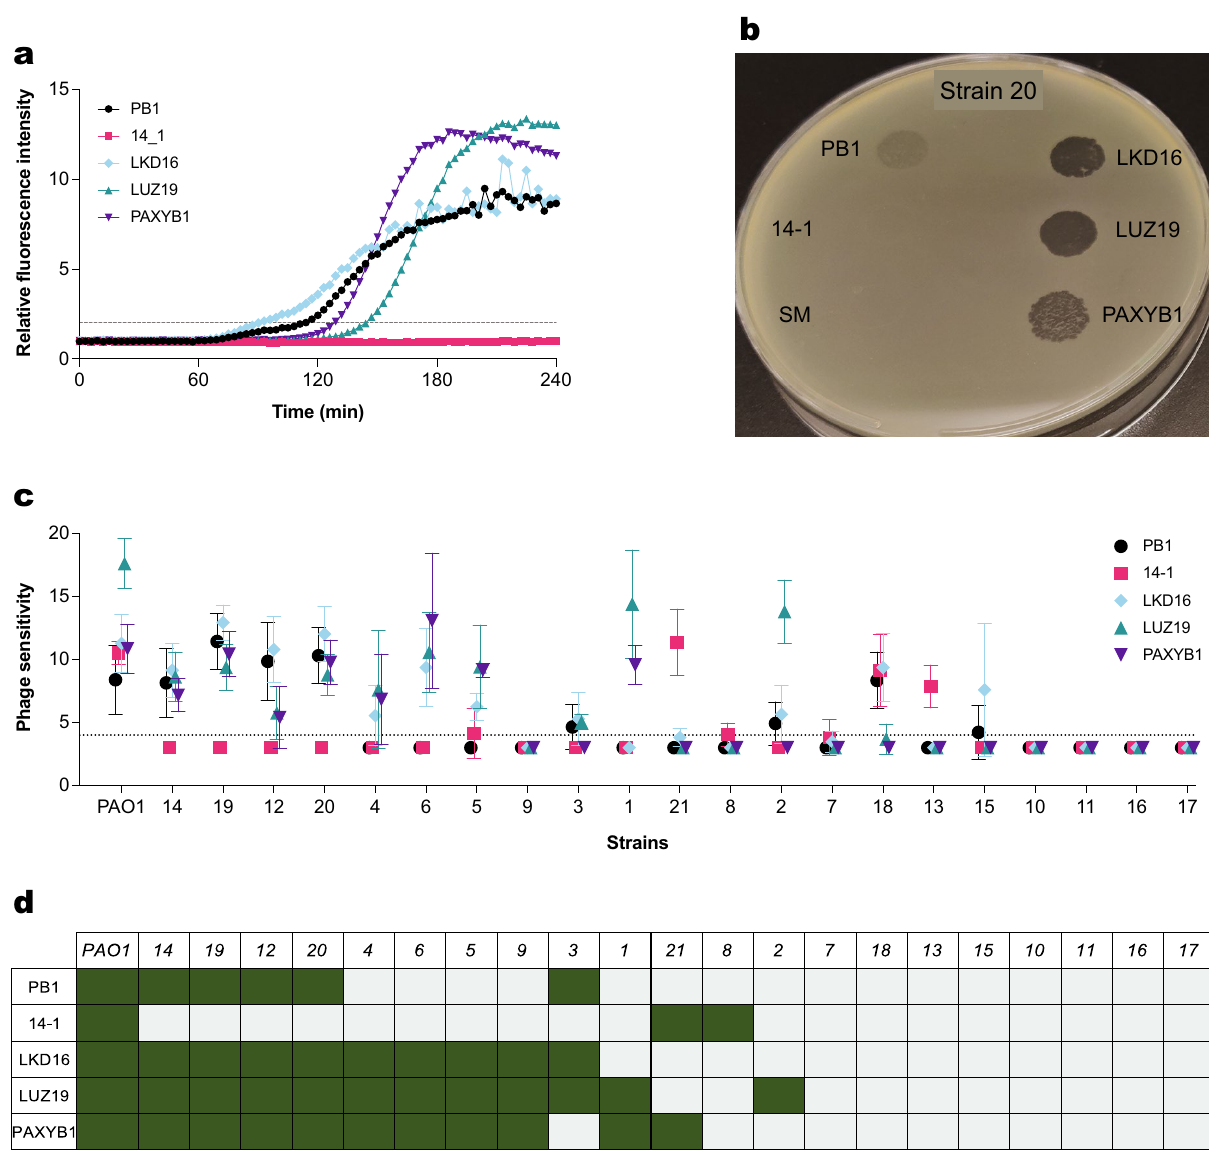
Figure 5. Phage susceptibility profiling of several P. aeruginosa clinical strains. ( a ) Strain 20 of the panel was incubated with phages PB1, 14-1, LKD16, LUZ19 or PAXYB1 at an MOI of 1 at 37 °C in the presence of Sytox green. Fluorescence intensity was measured using a fluorometer, and values were divided by control signal to obtain relative fluorescence intensity. Black dotted line represents threshold for phage-mediated damage (relative fluorescence = 2). A representative graph of at least three independent experiments is shown. ( b ) Strain 20 of the panel was inoculated into top agar and overlayed on a plate. Phages PB1, 14-1, LKD16, LUZ19 and PAXYB1 (10 6 pfu/mL, 5 μL) and SM buffer (5 μL) were spotted to detect plaque formation after overnight incubation at 37 °C. ( c ) Summary of the susceptibility of P. aeruginosa strains to 5 different phages found with the fluorescent DNA dye assay. Phage sensitivity was defined as 1/time of damage * 1000 (min −1 ). A higher value reflects faster induction of phage-mediated damage. Black dotted line represents time detection limit in this assay (240 min). Data represent mean ± SD of three independent experiments. ( d ) Summary of the susceptibility to 5 different phages determined through plaque assays. Green indicates sensitivity to the phage (plaques were found), gray indicates no sensitivity (no plaques or barely